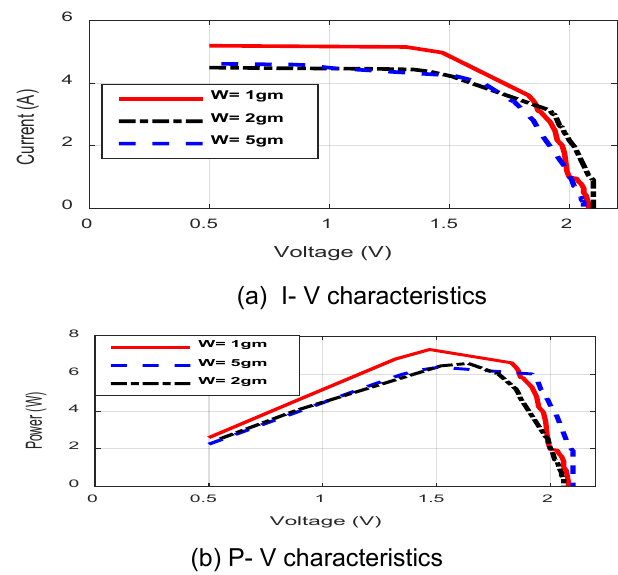
Figure 15. I-V and P-V characteristics of sugar mill bagasse dust with reflector at 500W/m 2